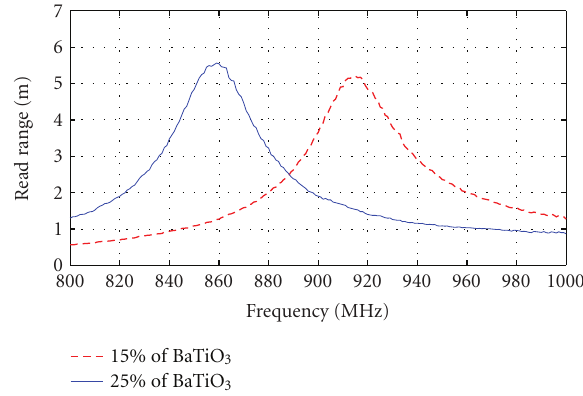
Figure 10: Calculated read range [ d tag ] in + z direction of the tag antenna, with 15% and 25% of BaTiO 3 concentration in the composite substrates, based on measured results and (3).